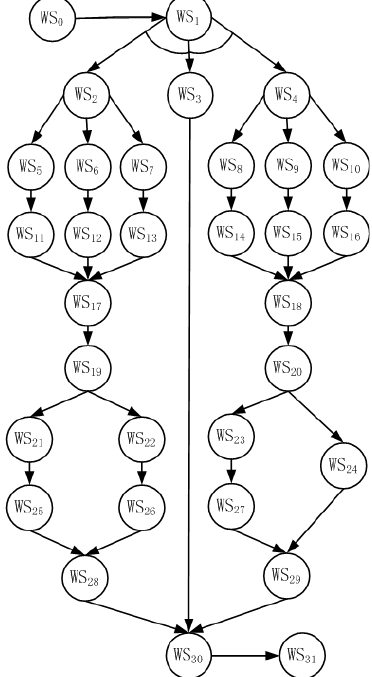
Fig. 5. An Instance System of Composite Service: SI3 (cid:7)